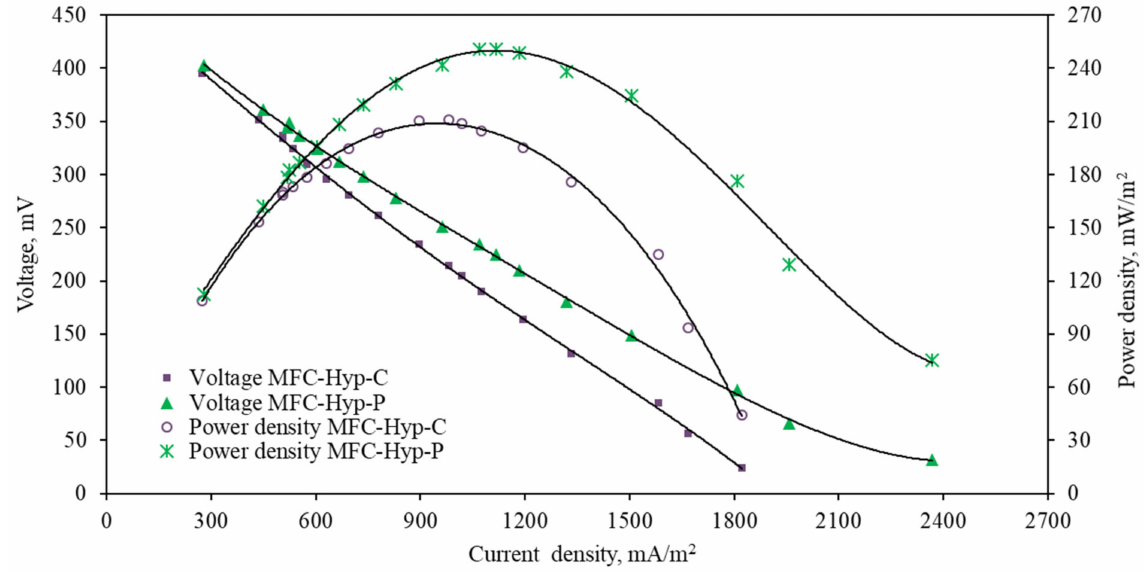
Figure 5. Polarization and power density curves for the MFC-Hyp system in the presence and absence of A. tuberosum : MFC-Hyp-P refers to the system with A. tuberosum ; MFC-Hyp-C refers to the control